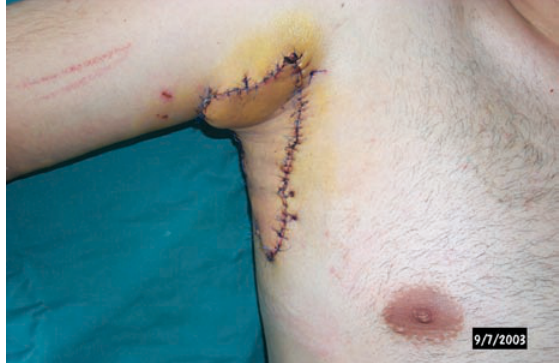
Figure 3. Reconstruction of the axilla with L. Dorsi myocutaneous island flap.